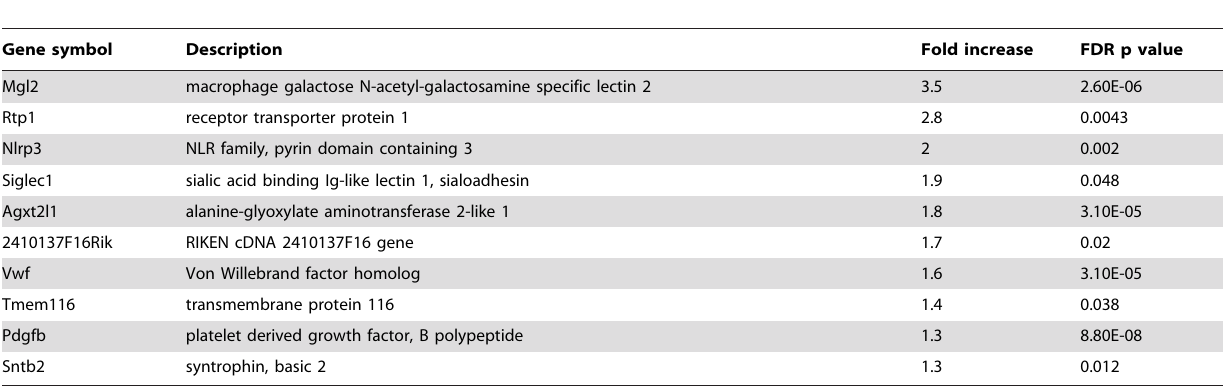
Table 3. E2-regulated genes with the most increased expression.